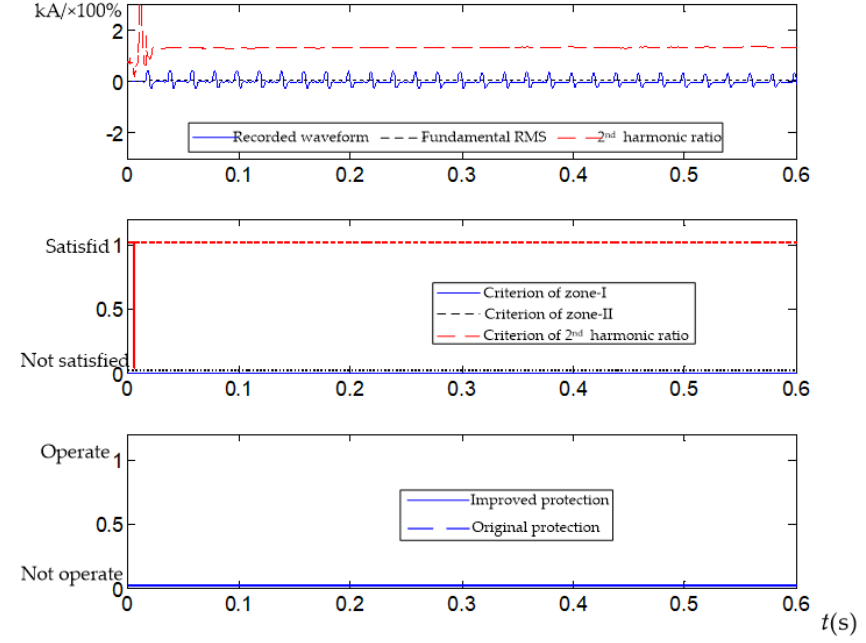
Figure 12. Protection behavior of waveform Number One.